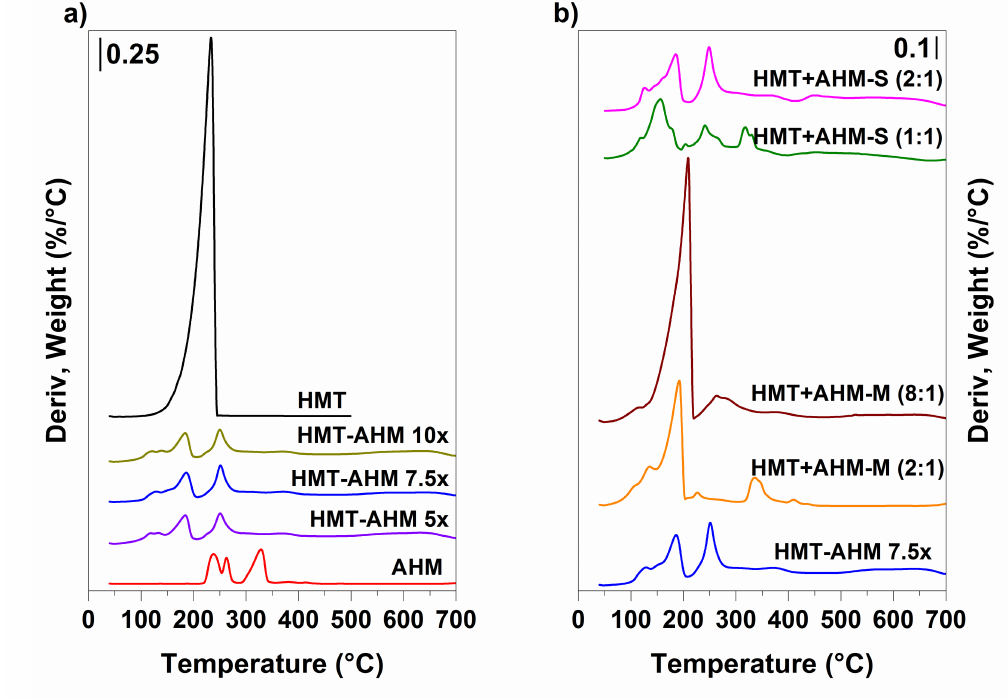
Figure 3. Thermogravimetric analysis of the synthesised precursors ( a ) and the starting feedstock ( b